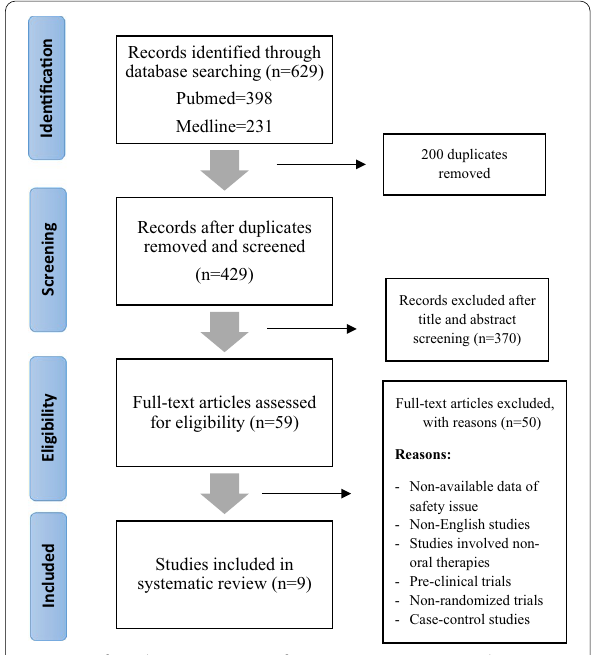
Fig. 1 Preferred reporting items for systematic reviews and meta-analyses (PRISMA) diagram of included